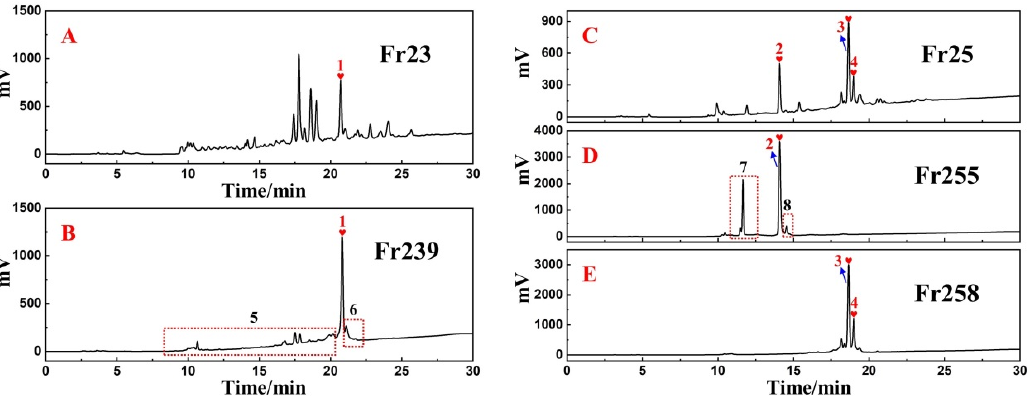
Figure 4. HPLC analysis of Fr23 and Fr239 ( A , B , respectively) on the Click XIon analytical column, with fractions Fr25, Fr255, and Fr258 also analyzed on the same type of column ( C – E , respectively). Analysis was performed at a flow rate of 1.0 mL/min, using a column temperature of 30 °C, with 0.1% v / v trifluoro ‐ acetic acid in water and acetonitrile (ACN) as mobile phases A and B, respectively, and with a gradient of 0–30 min using 100–60% B. The chromatograms were obtained at a wavelength of 210 nm. Peaks 1 ‐ 4 represent active fraction peaks, respectively. Peaks 5 ‐ 8 represent impurity peaks.